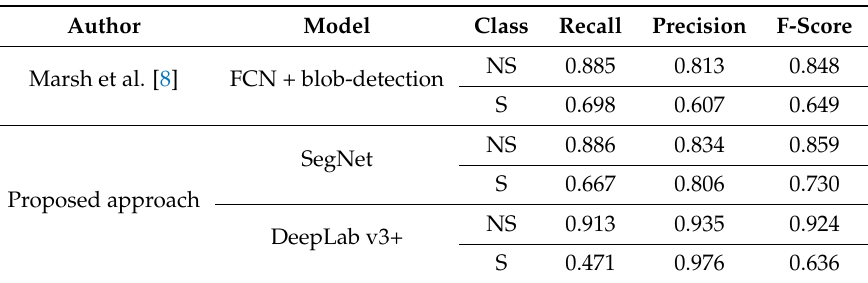
Table 12. Performance Comparison for Detection